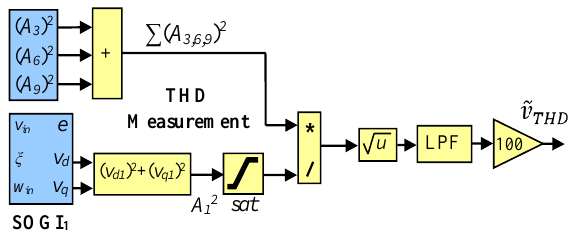
Figure 6. Block diagram of the MSOGI-FLL THD method.